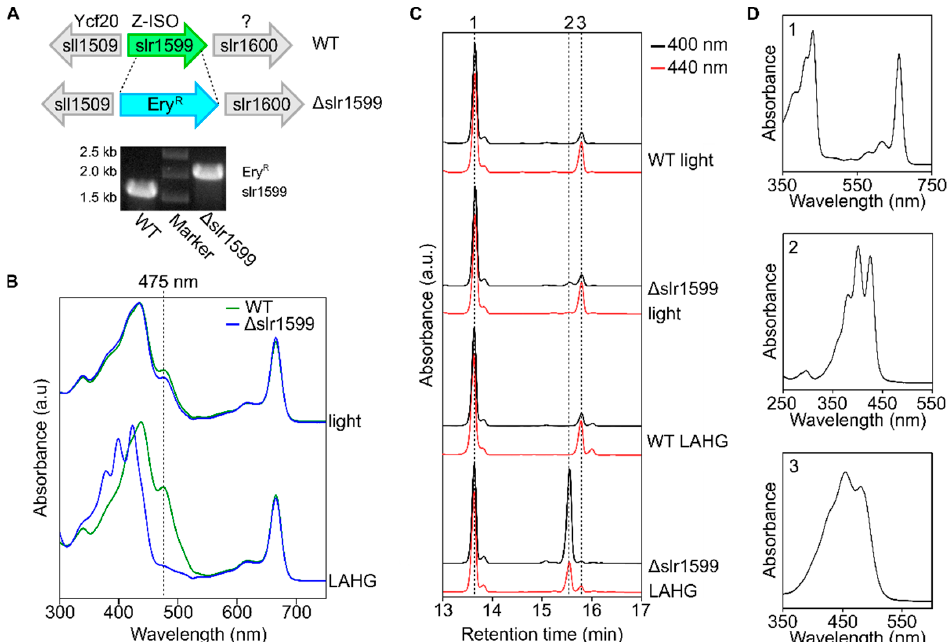
Figure 4. Carotenoid composition of WT and Δ slr1599 strains of Synechocystis grown under photoautotrophic and LAHG conditions. ( A ) Schematic showing generation of the Δ slr1599 Synechocystis mutant by partial replacement of slr1599 (green) with the erythromycin resistance gene (Ery R ) by homologous recombination (indicated by the dotted lines). Segregation of the mutant was confirmed by PCR amplification of the slr1599 locus in comparison to the isogenic WT parent strain. ( B ) Absorbance spectra of methanolic extracts of the WT (green trace) and Δ slr1599 (blue trace) strains grown under constant illumination (light) or LAHG conditions. The black dotted line highlights the contribution of ‘mature’ carotenoids to the WT spectra at ~475 nm, which is largely depleted in the mutant under LAHG conditions. ( C ) RP-HPLC analysis of pigments extracted from WT and Δ slr1599 cells grown under photoautotrophic (light) or LAHG conditions. Chlorophyll (peak 1), 9,15,9’-tri- cis - ζ -carotene (peak 2) and β -carotene (peak 3) were detected by monitoring absorbance at 400 nm (black traces) and 440 nm (red traces); traces are normalized to the height of the Chl peak. ( D ) Absorbance spectra of the numbered pigment species in panel ( C ).